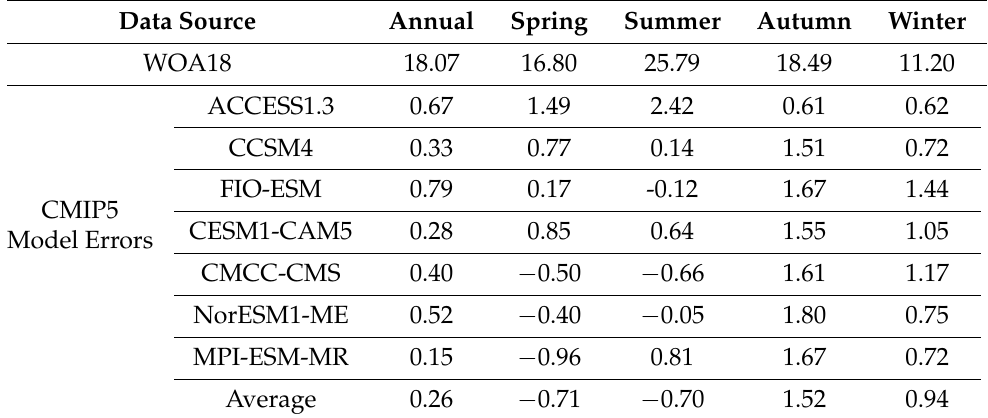
Table 2. Comparison of CMIP5 model data with the real observation data from WOA18 in